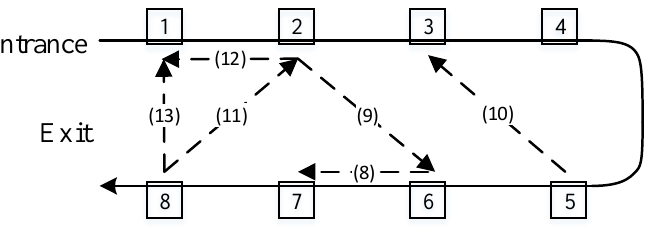
Figure 7. Illustration of walking paths. Equation (14) calculates the walking times of operators in all workstations. The total production time and walking time in a workstation is the cycle time of the workstation and cannot exceed the cycle time given in Equation (15). Equation (16) restates the definitions of binary